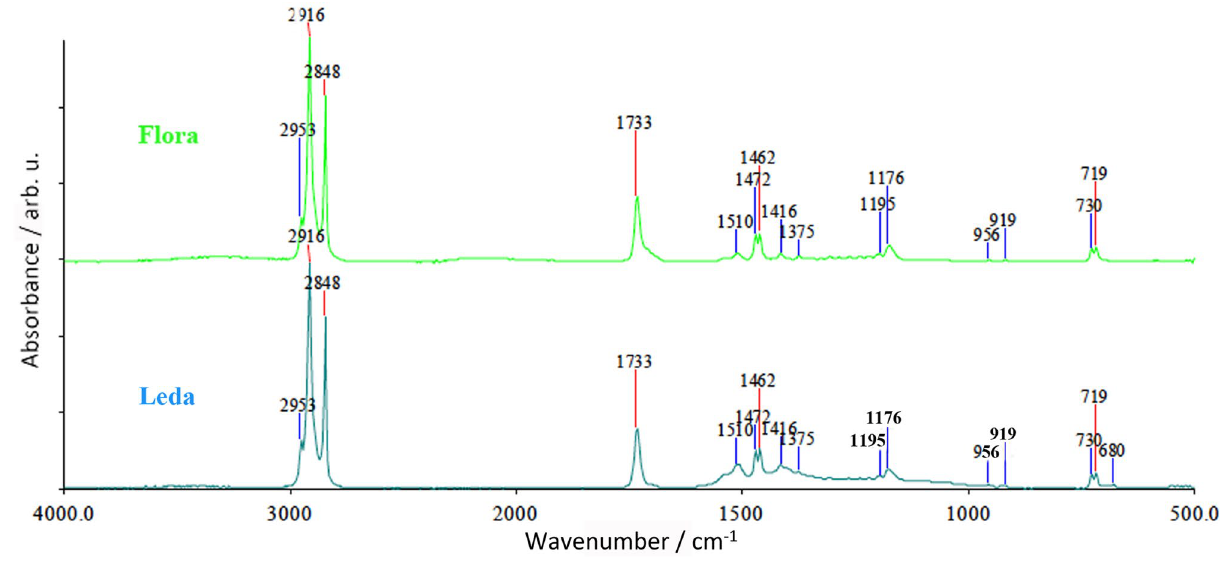
Figure 2. FT-IR spectra of the sample F1 of the Flora bust (above) compared to that of the sample Leda 1